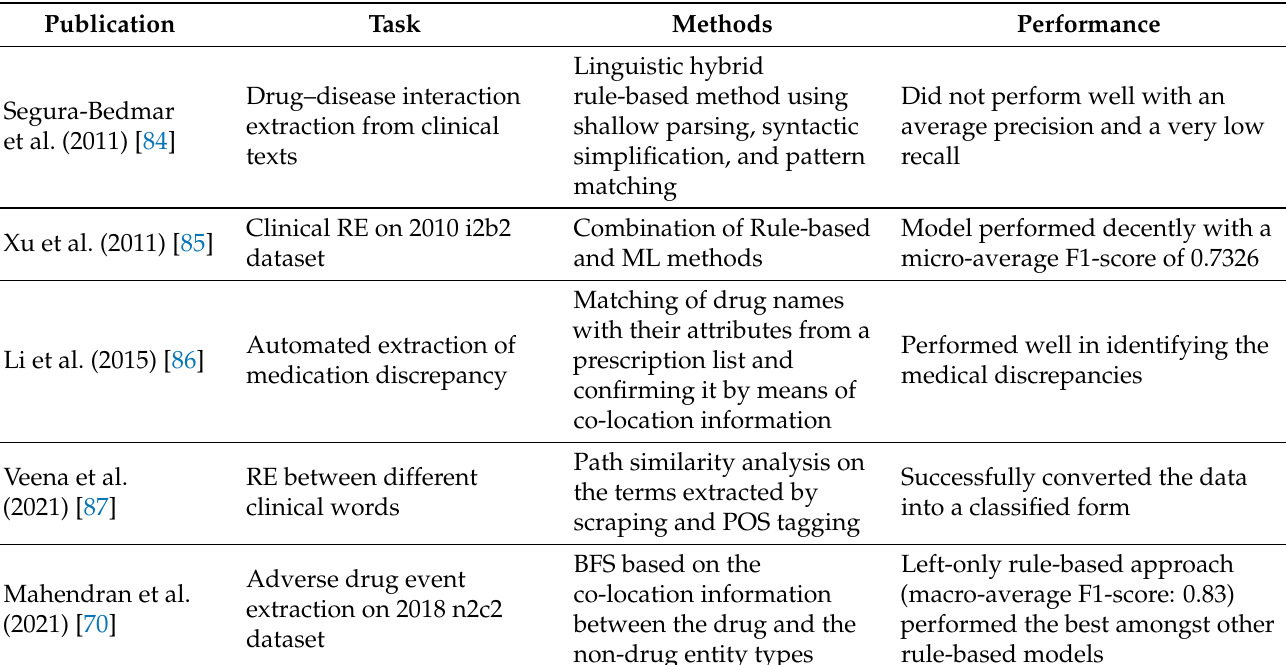
Table A3. Summary of the rule-based approaches for clinical